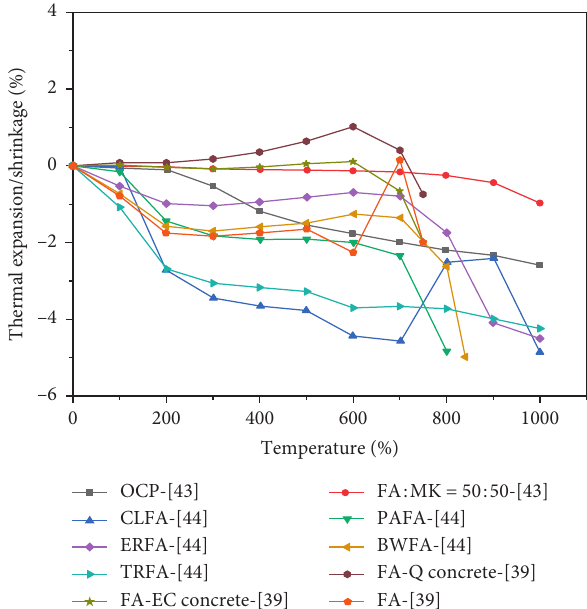
Figure 2: Changes in thermal deformation of geopolymers pastes and concretes at elevated temperatures. Note: Q represents quartz aggregate and EC represents expanded clay